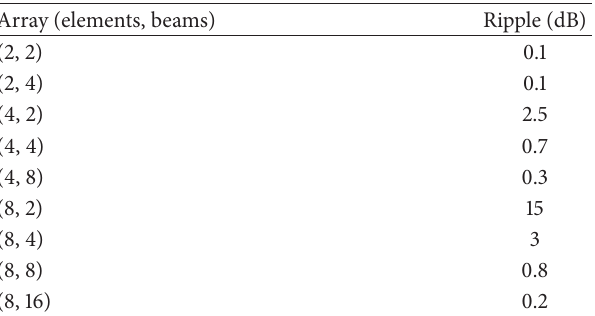
Table 2: Average ripple between the maximum of lobe and the adjacent